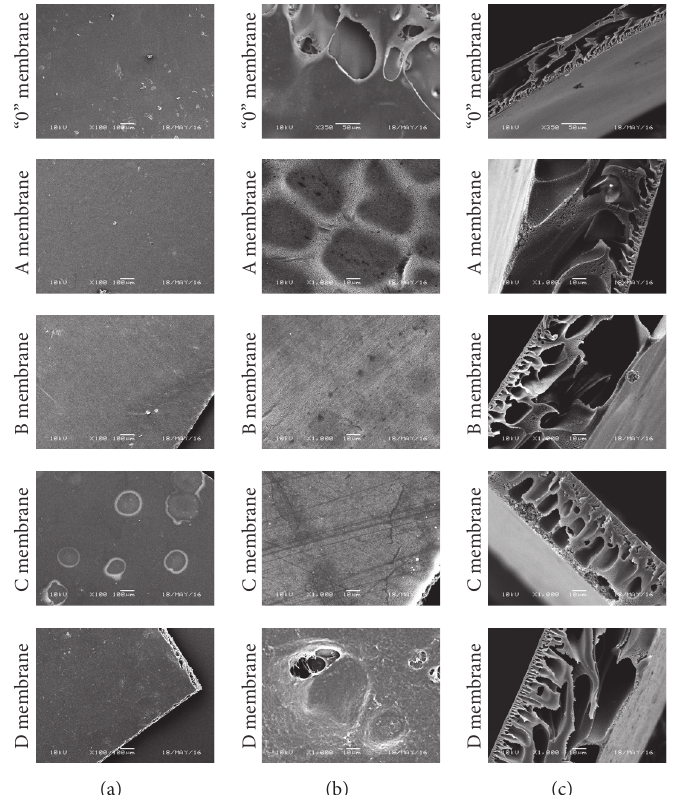
Figure 6: Microphotographs (SEM) of pure PAN and polyaniline-modified membrane cross sections: (a) skin layer; (b) bottom layer; and (c) cross